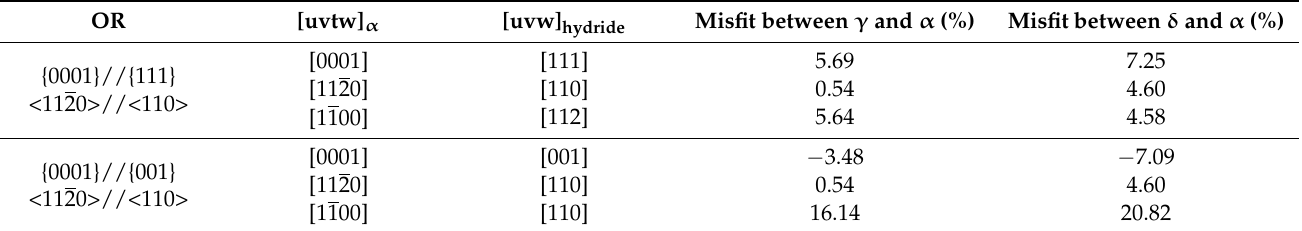
Table 1. The misfit between the hydride and Zr matrix with two different ORs [66]. Reprinted with permission from [66]; Copyright 2022 Table 1. The mis fi t between the hydride and Zr matrix with two di ff erent ORs [66]. Reprinted with permission from [66]; Copyright 2022 Elsevier.